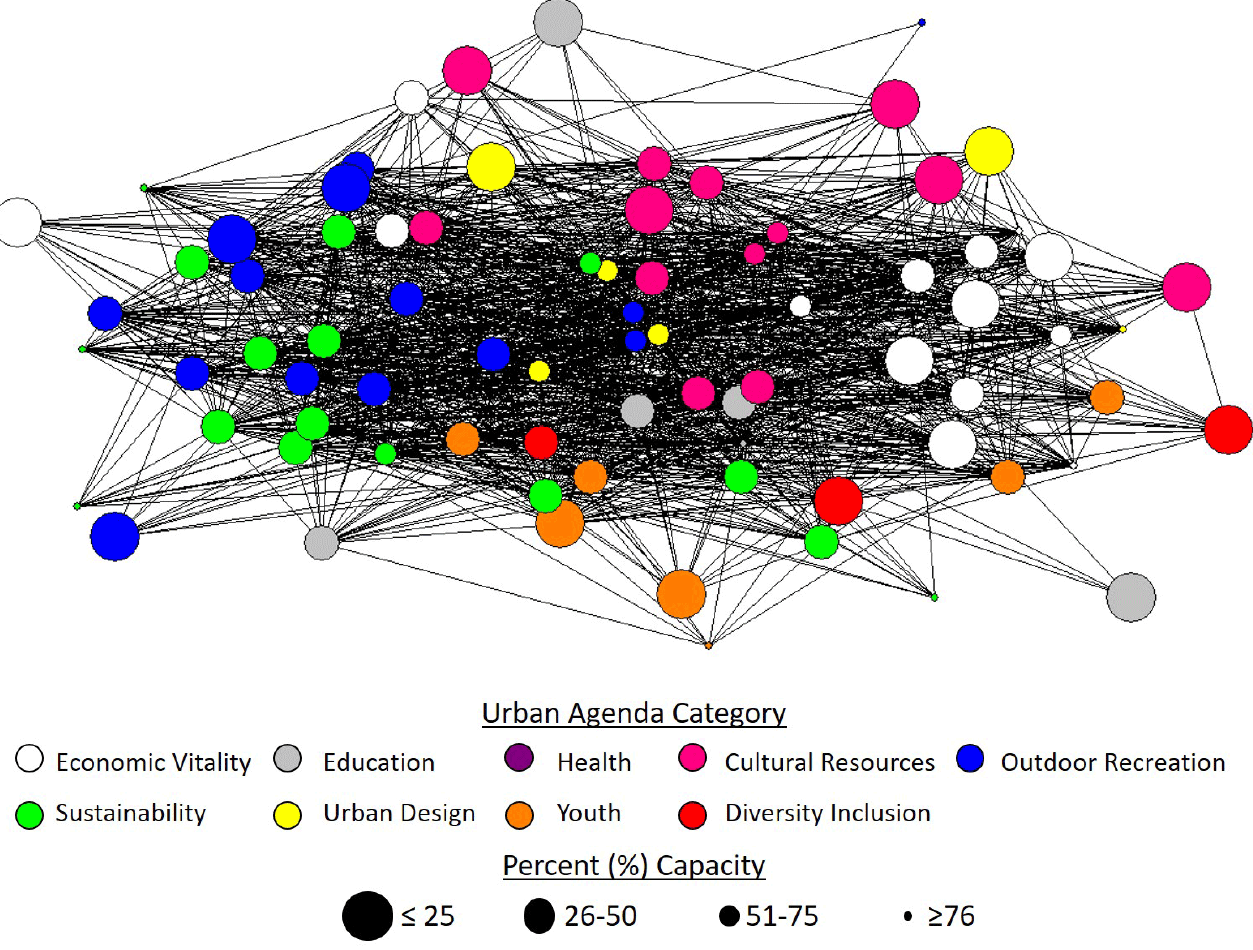
Fig. 1 . National Park Service present urban collaborative network in Detroit. Actors colored by organizational category and sized by quartiles of percent capacity of all G&F brokerage roles, with larger actors representing lower percent capacity and more potential for